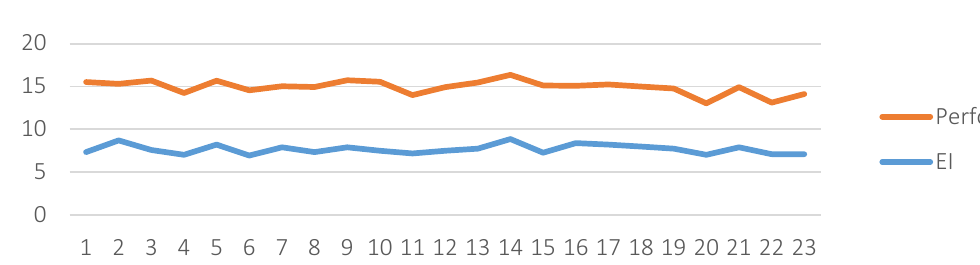
Figure 3. Correlation between EI of female students and their performance